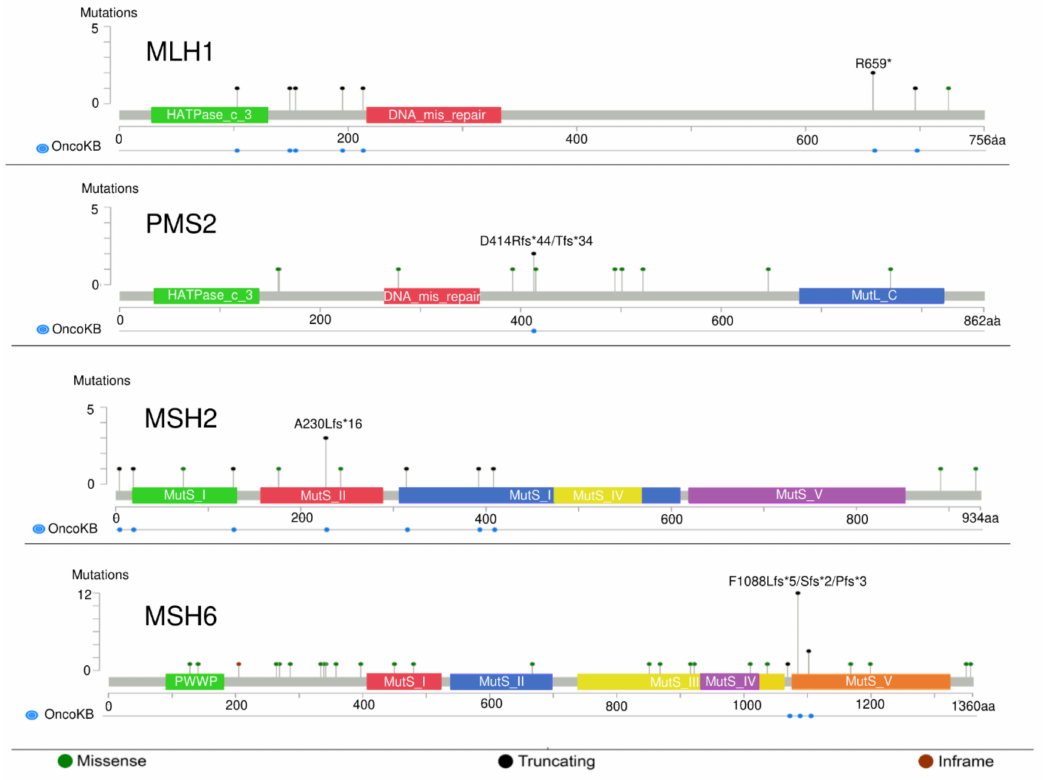
Figure 3. Type of mutations, frequency, and a ff ected MMR proteins domains in gastroesophageal cancers (GEC) included in the analysis from cbioportal.com. No inframe mutations were observed. All truncating mutations are labeled as likely oncogenic by